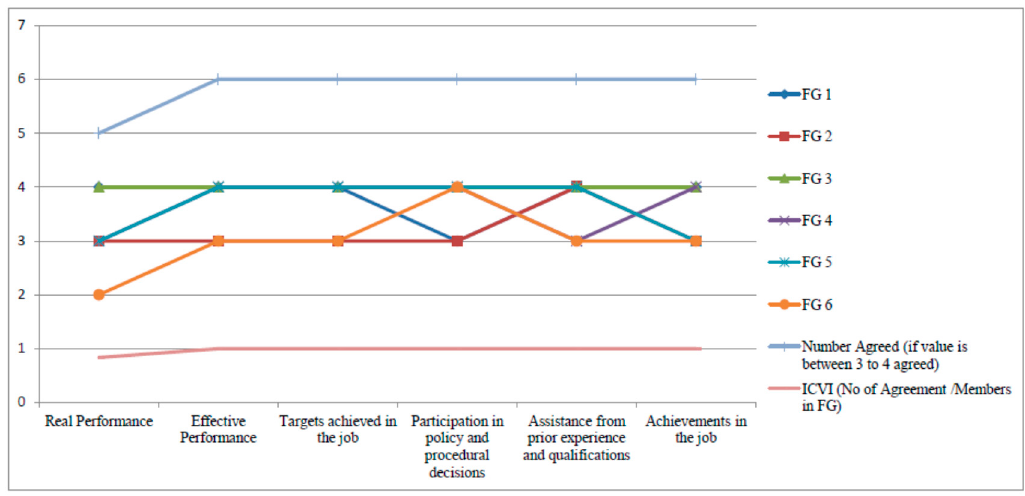
Figure 4. Individual Item Content Validity (ICVI) (All items that have ICVI values more than 0.78 were considered for the questionnaire) calculations of performance of HL practitioners (Source: Survey data).